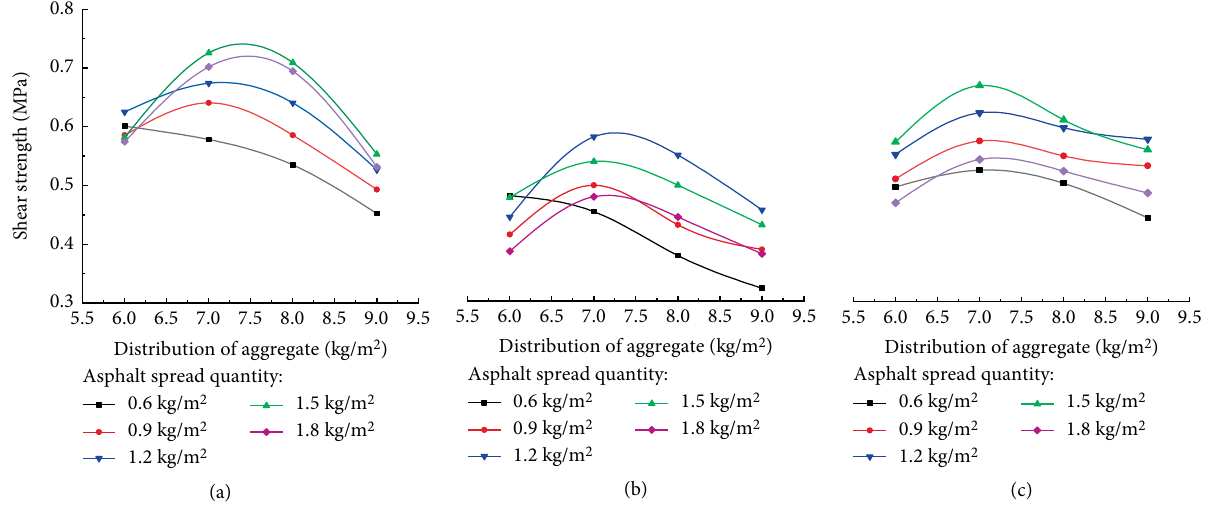
Figure 12: Shear strength of specimens with precoated interlayer treatment: (a) SBS-modified asphalt, (b) SBS-modified emulsified asphalt, (c) ordinary hot asphalt.